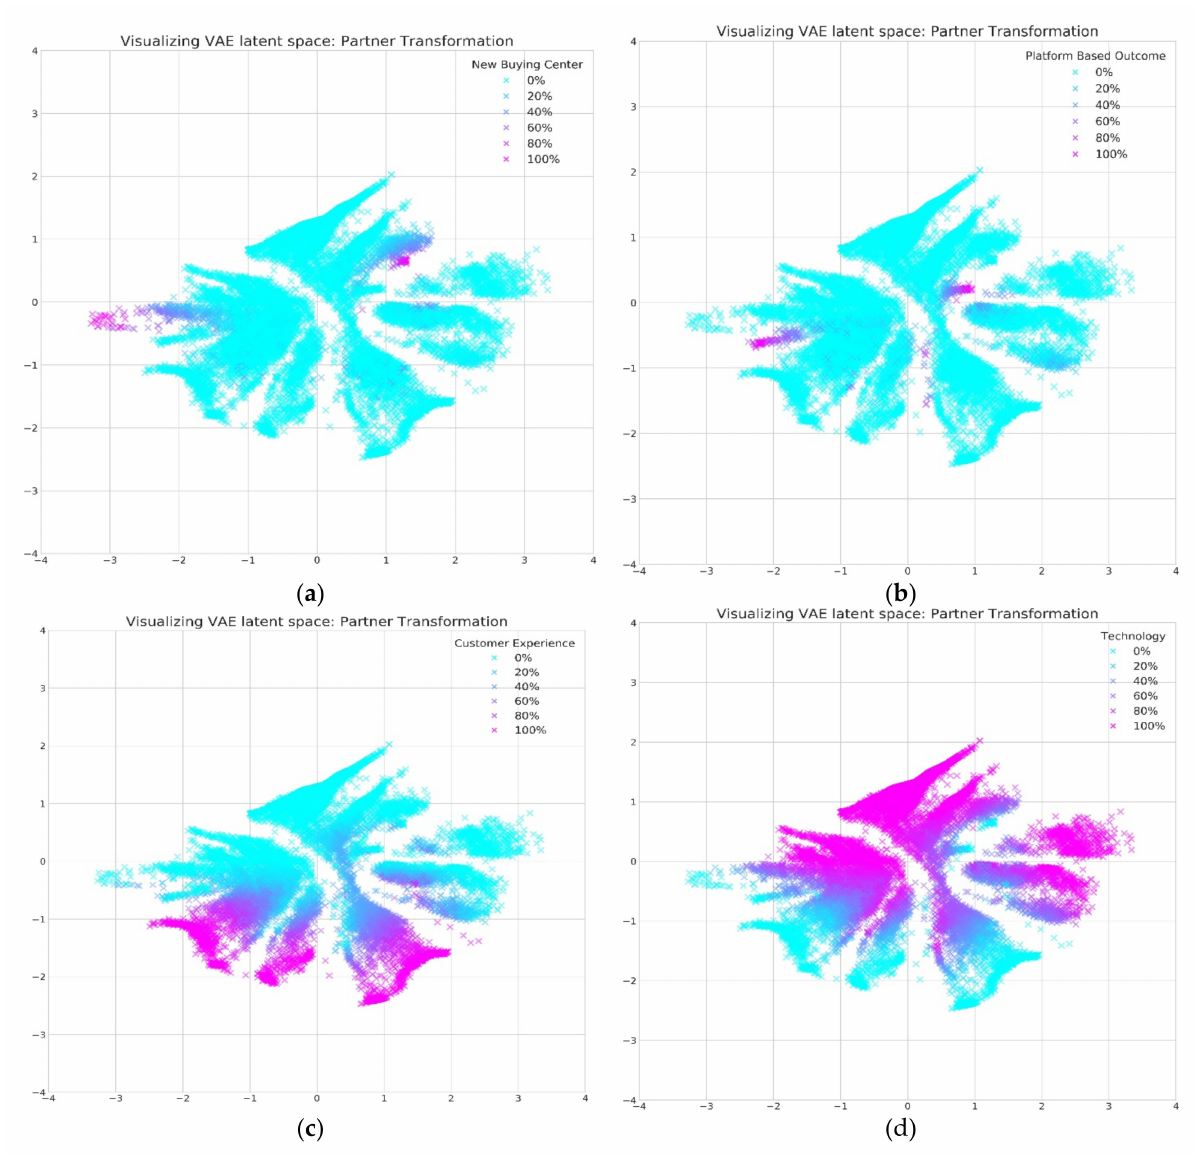
Figure 4. ( a )Visualization of the new buying center transformation dimensions in the 2-D latent space; ( b ) Visualization of the platform-based outcome transformation dimensions in the 2-D latent space; ( c ) Visualization of the customer experience transformation dimensions in the 2-D latent space; ( d ) Visualization of the technology transformation dimensions in the 2-D latent